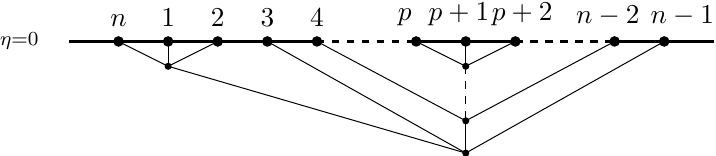
Figure 17 . Witten diagram corresponding to A ( I n :1( p + 1) , 2 n, . . . , p ( p + 2)) C ∆